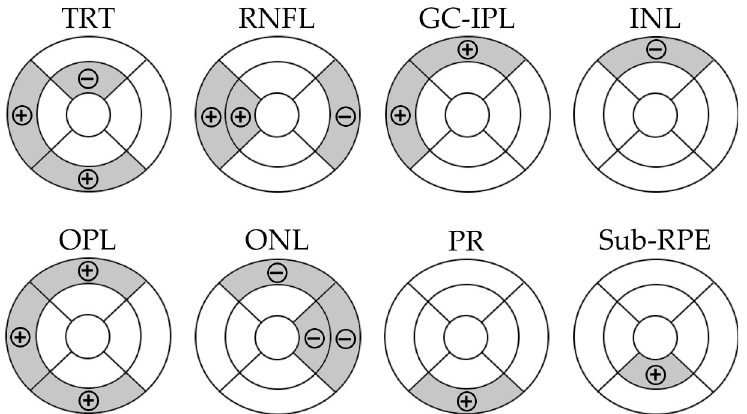
Fig 4. ETDRS maps demonstrating sectors that showed changes in retinal thickness following laser therapy. Shaded sectors indicate a statistically significant change in retinal thickness; (+) indicates an increase in thickness and (–) indicates a decrease in